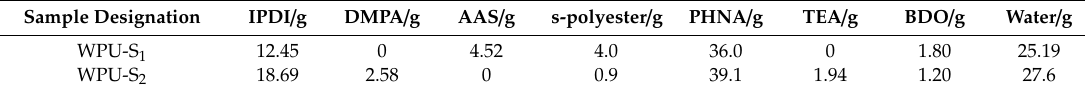
Table 1. The formulation of small-particle waterborne polyurethane